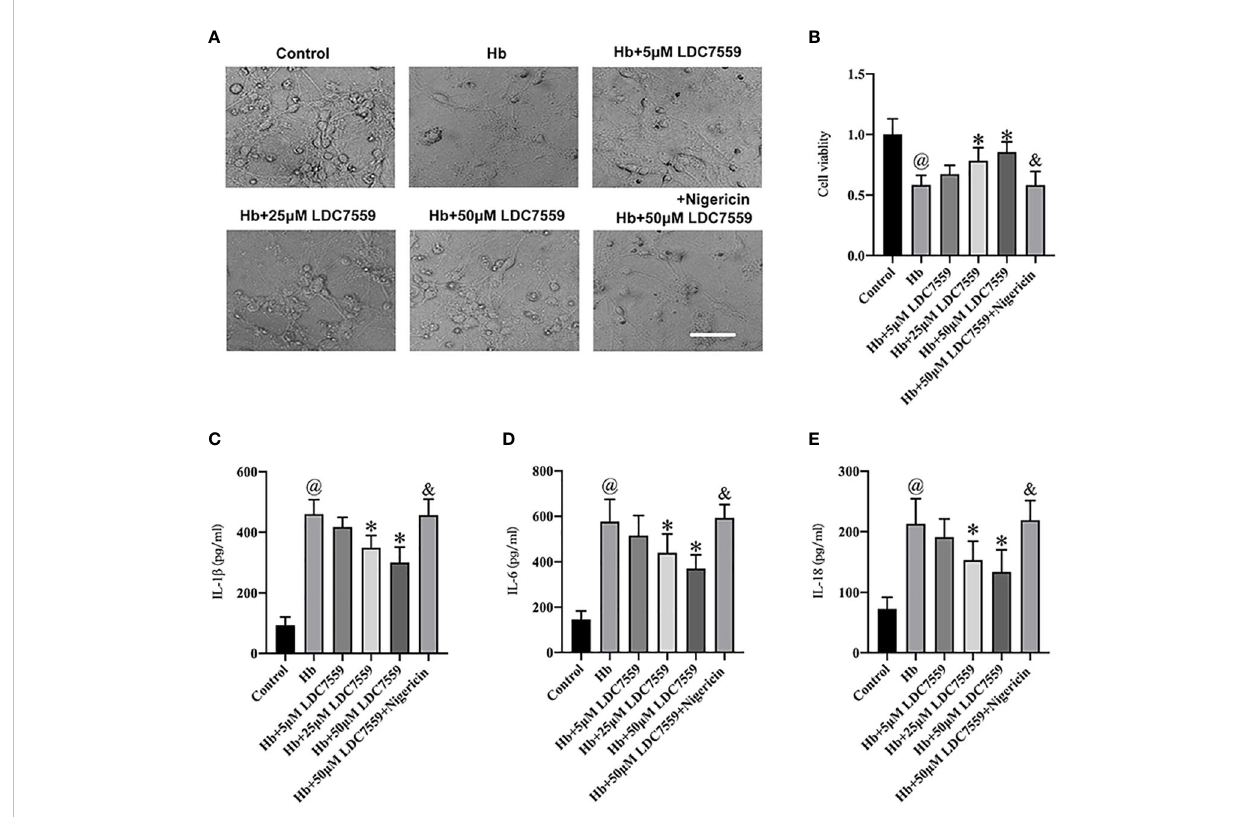
FIGURE 5 LDC7559 improved cell viability and reduced in fl ammatory response in vitro experiments. Phase-contrast photomicrographs of cultured neurons in all groups (A) . Scale bar = 50 m m. Changes of cell viability were determined by CCK-8 assay (B) (n = 6 per group). ELISA kits were used to determine the levels of IL-1 b (C) , IL-6 (D) , and IL-18 (E) (n = 6 per group). Values are presented as the mean ± SD. @ P < 0.05 compared with control group, * P < 0.05 compared with Hb group, & P < 0.05 compared with Hb + 50 m M LDC7559 group.